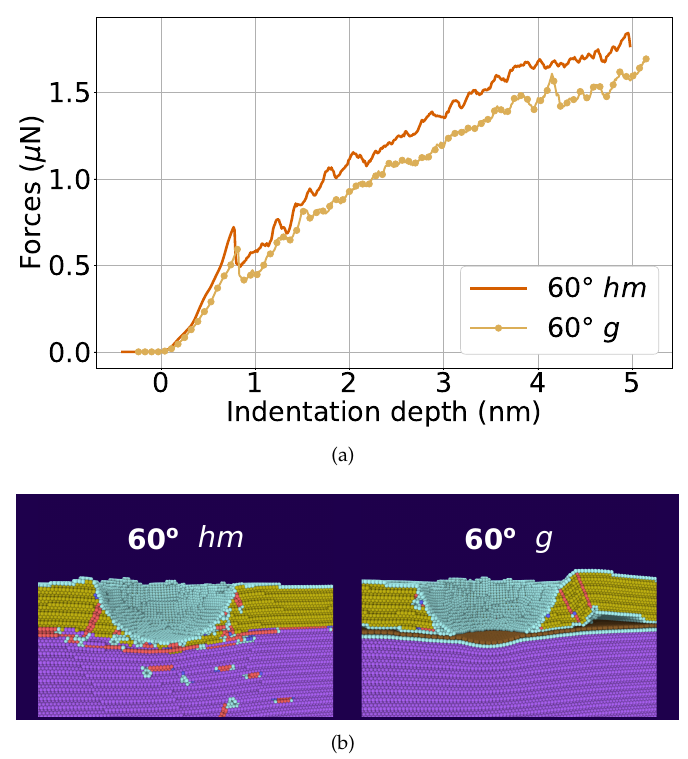
Figure 9. Comparison of the indentation into a Ni bi-crystal with a 60 ◦ twist boundary without hm and with g graphene. ( a ) averaged force–depth curves; ( b ) snapshots showing the microstructure at an indentation depth of d = 4.2 nm. Atoms are colored according to common-neighbor analysis. Purple: fcc (lower Ni block); gold: fcc (lower Ni block); red: stacking faults; cyan: other defects; brown: graphene.